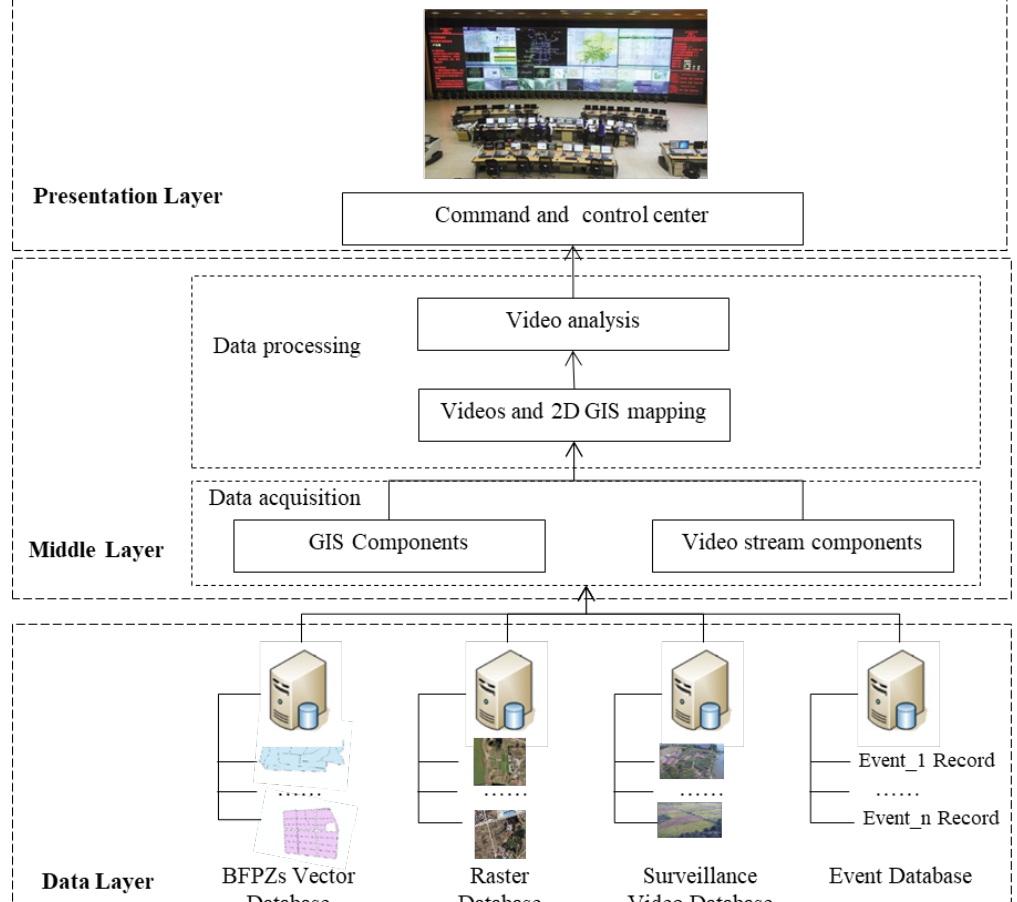
Figure 6. Framework diagram of the proposed comprehensive monitoring method for cultivated land